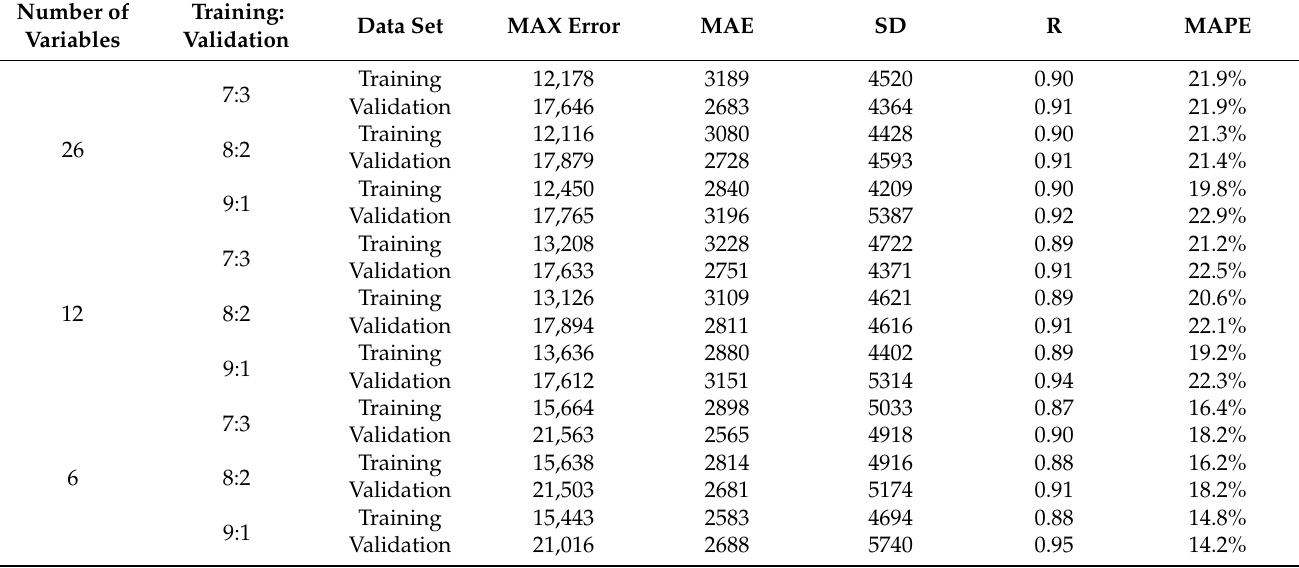
Table A2. Analysis of the results of the SR model for electricity